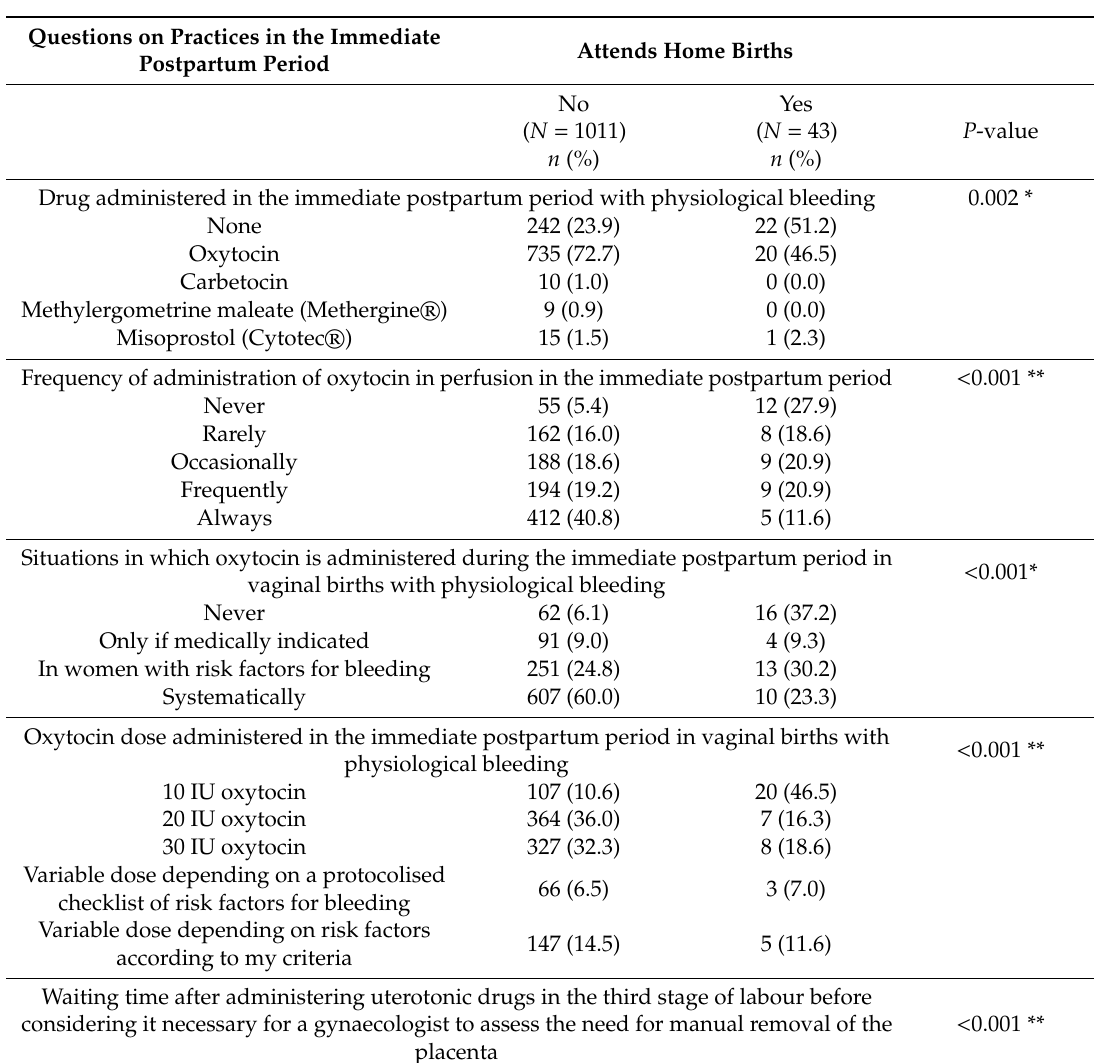
Table A1. Attendance at home births and practices in the immediate postpartum